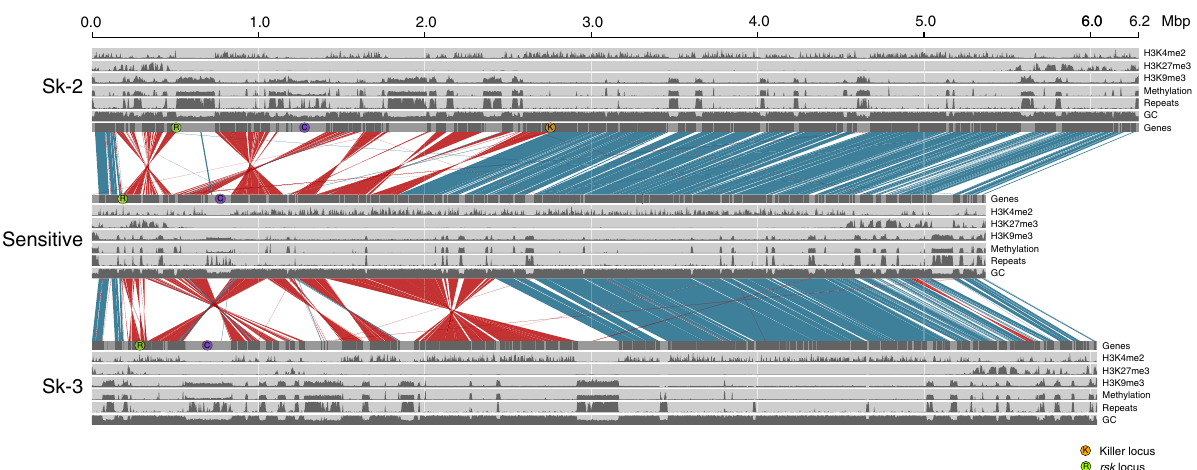
Fig. 1 An alignment of chromosome 3 in Sk-2 and Sk-3 to sensitive Neurospora intermedia , which retains the ancestral gene order, shows a series of large inversions in the region between the killer and resistance loci. Blue color shows collinear regions and red inverted regions. All inversions are different between Sk-2 and Sk-3 and are interspersed with gene-poor and repeat-rich inserted regions. The location of the Sk-2 killer locus us marked with an orange circle and the rsk (resistance) locus and the centromeres are marked with green and purple circles, respectively. Tracks in gray show genes; GC content; repeat content; cytosine methylation; and H3K9me3, H3K27me3, and H3K4me2 histone methylation. H2K9me3 is a mark for constitutive heterochromatin, which in Neurospora is highly associated with repeats; H3K27me3 is a mark for facultative heterochromatin, which is primarily found in subtelomeric regions; and H3K4me2 is a mark for euchromatic regions. Cytosine methylation and the three different histone modi fi cations were estimated using three biological replicates, and here the sum of the triplicates are presented